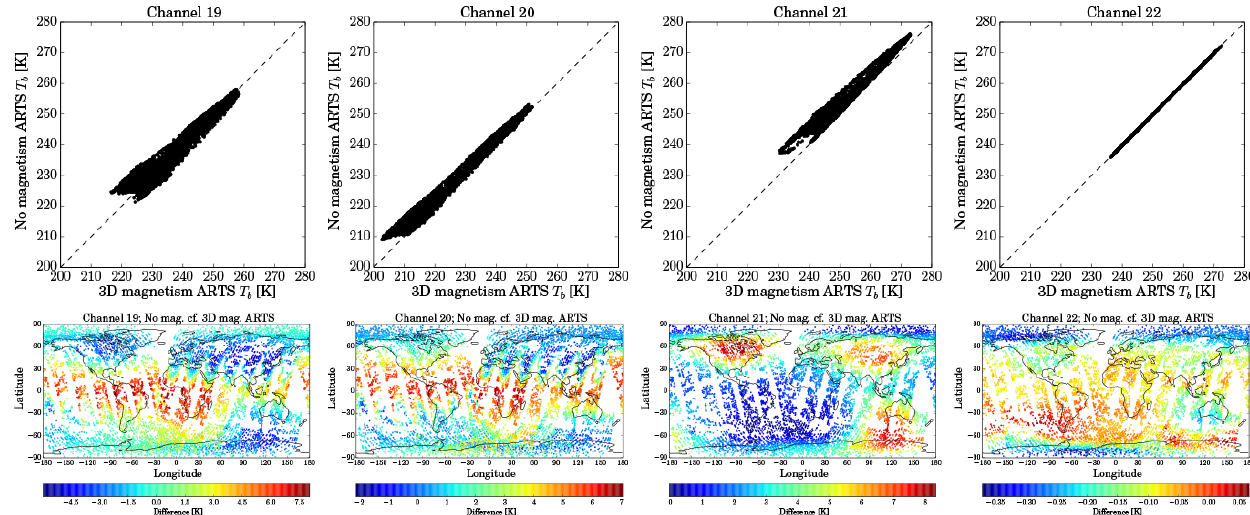
Figure 12. The Zeeman effect in ARTS for all four channels. Colors correspond to ARTS without any magnetic field minus ARTS with a three-dimensional magnetic